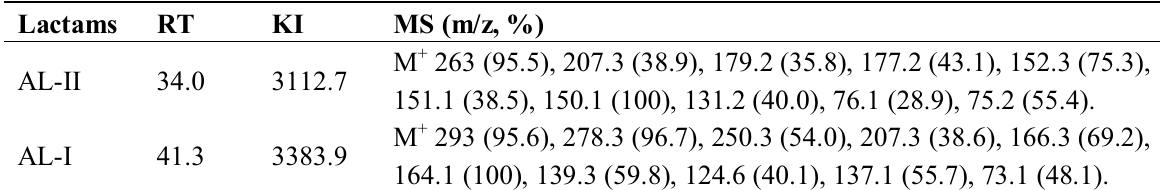
Table 1. Gas-chromatography mass spectrometry of aristolactam I and